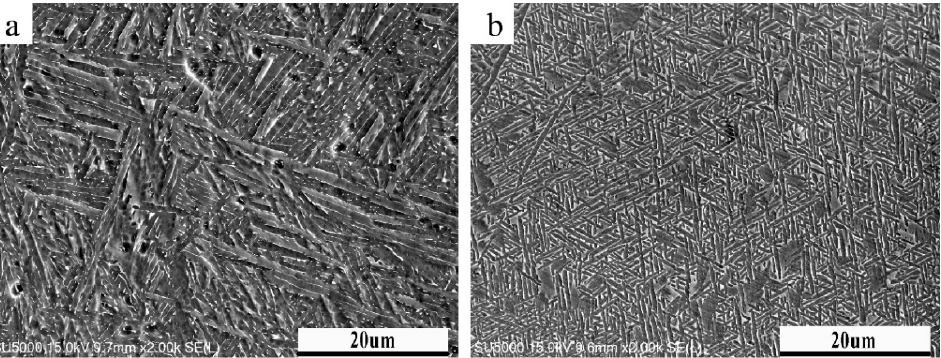
Figure 11. Scanning electron microscope (SEM) photographs of Ti-6Al-4V alloy under different line offset: ( a ) line offset is 0.16 mm; ( b ) line offset is 0.28 mm.